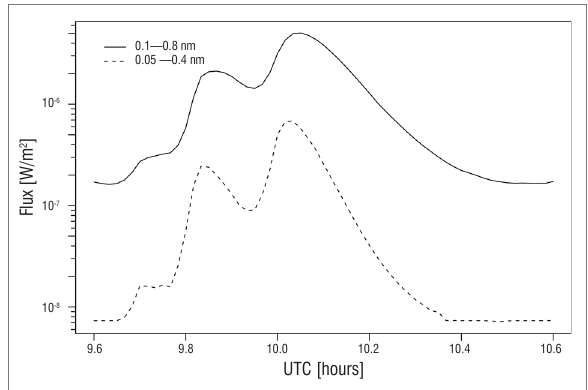
Figure 3: GOES-10 X-ray flux data for 13 December 2007 in the 0.05–0.4 nm and 0.1–0.8 nm bands.